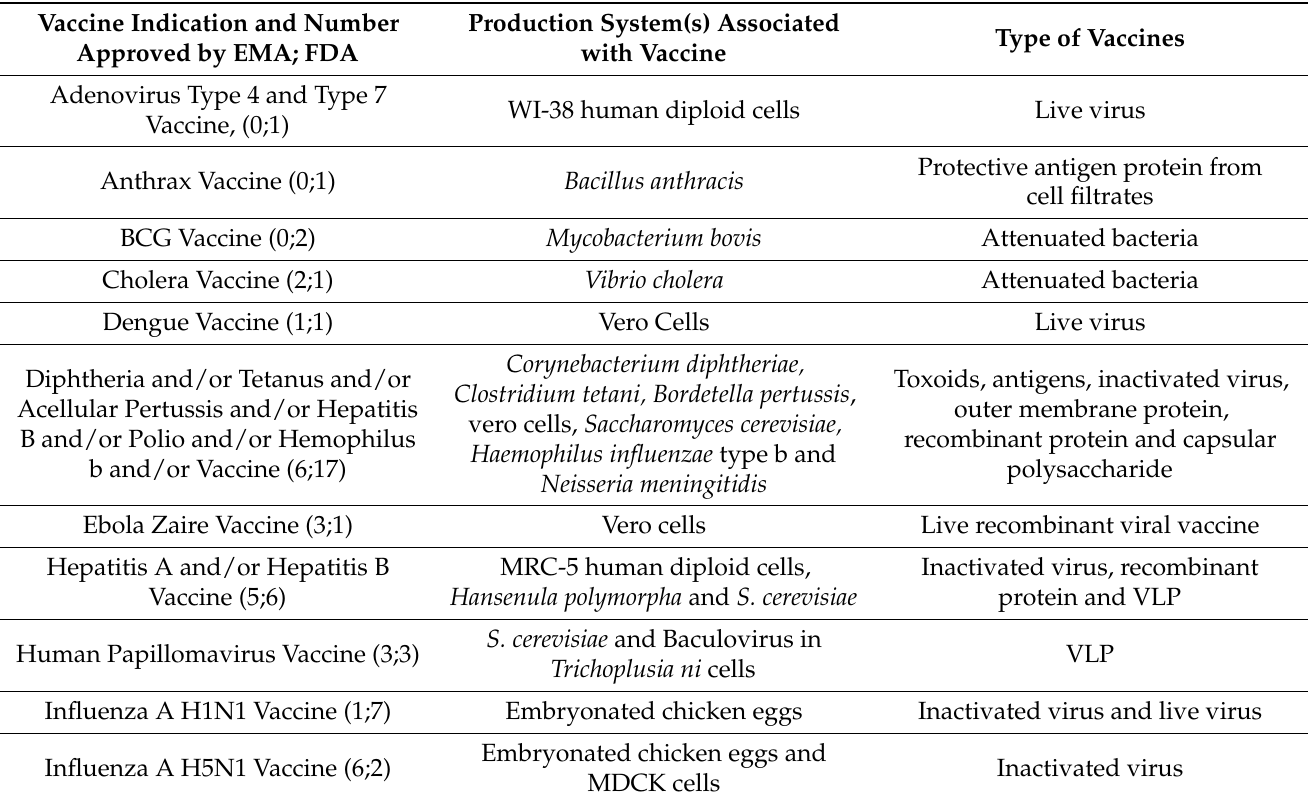
Table 2. European Medicines Agency (EMA) and FDA Approved Vaccines 2020